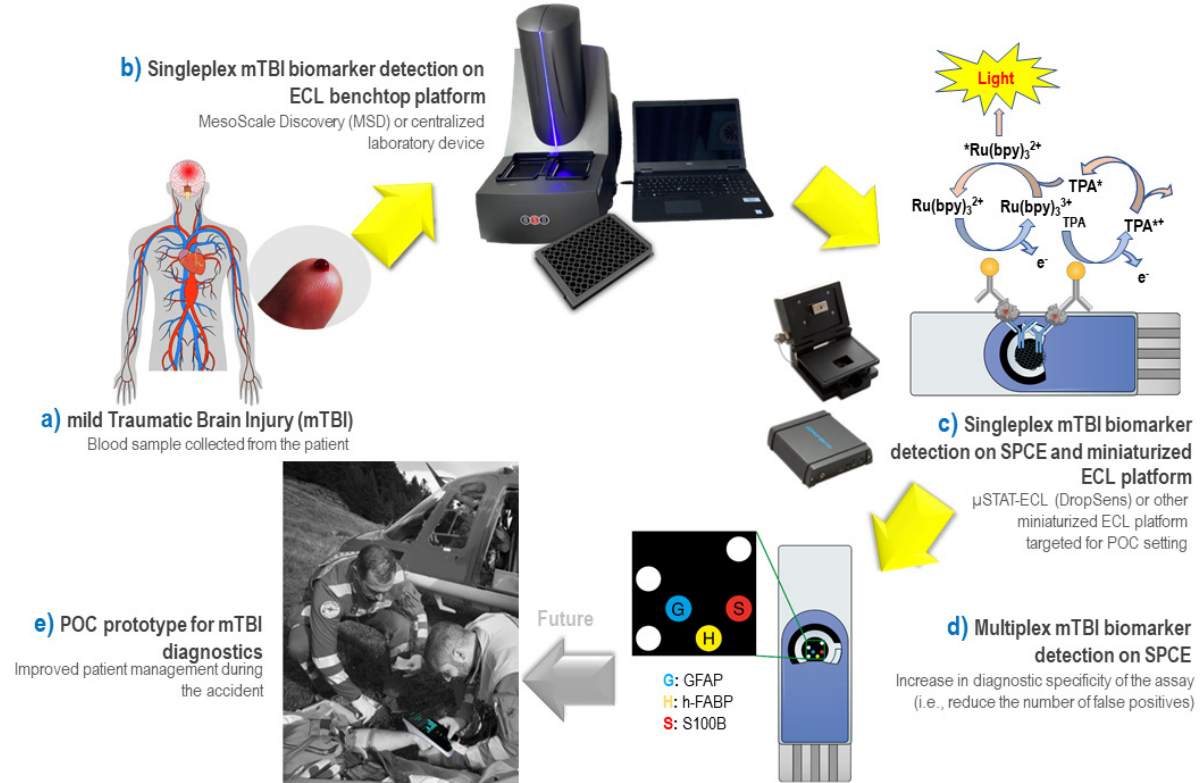
Scheme 1. Schematic representation of a strategy proposed for the detection of blood proteins for mild traumatic brain injury (mTBI) diagnostics: ( a ) Illustration of the human body suffering from an mTBI injury and collection of blood sample potentially containing mTBI-relevant protein biomarkers. ( b ) Development of ECL-based sandwich immunoassay for each individual mTBI-rele-